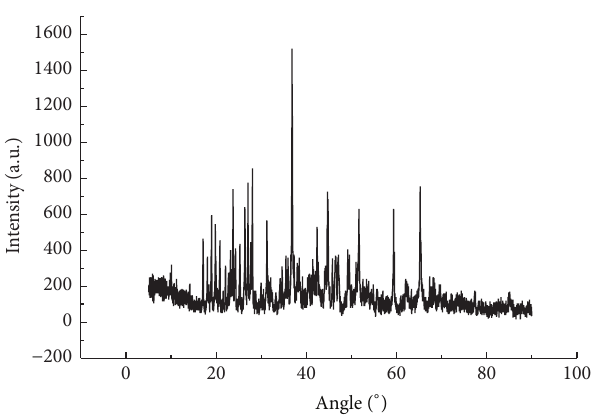
Figure 4: XRD patterns for leached boron samples.